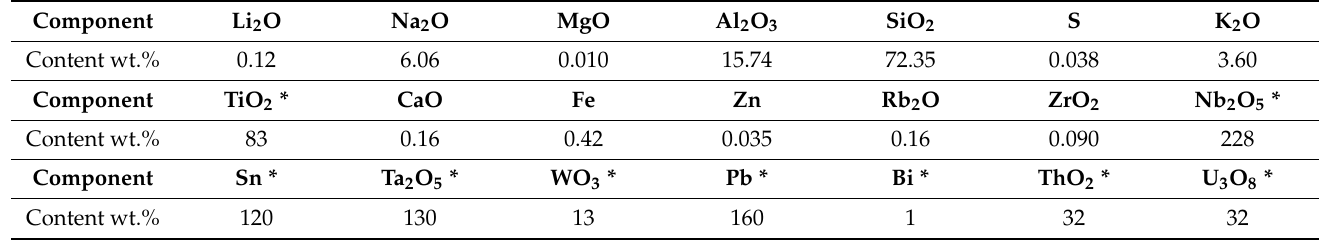
Table 1. Chemical analysis of ore sample.